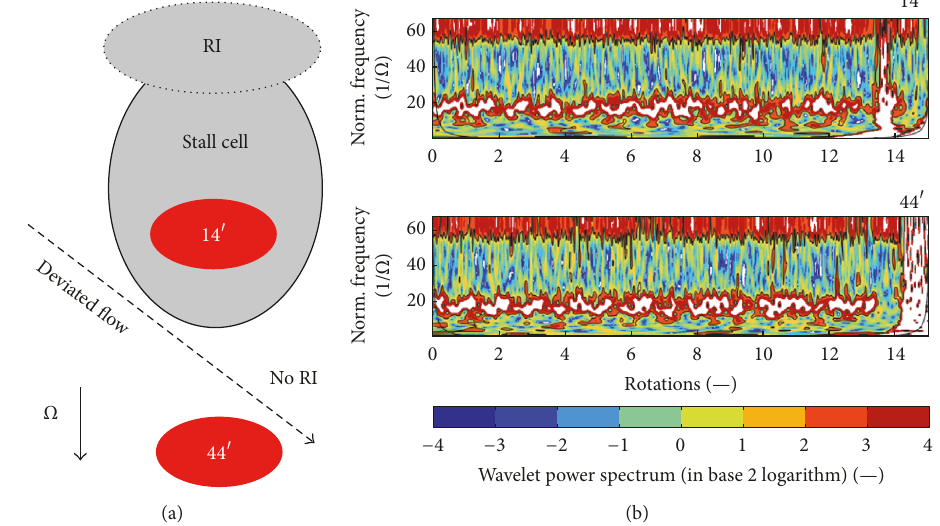
Figure 12: Rotating instability trace in wavelet analysis (b) and sketch (a) based on two signals positioned upstream of rotor 1 at 14 󸀠 and 44 󸀠 (red